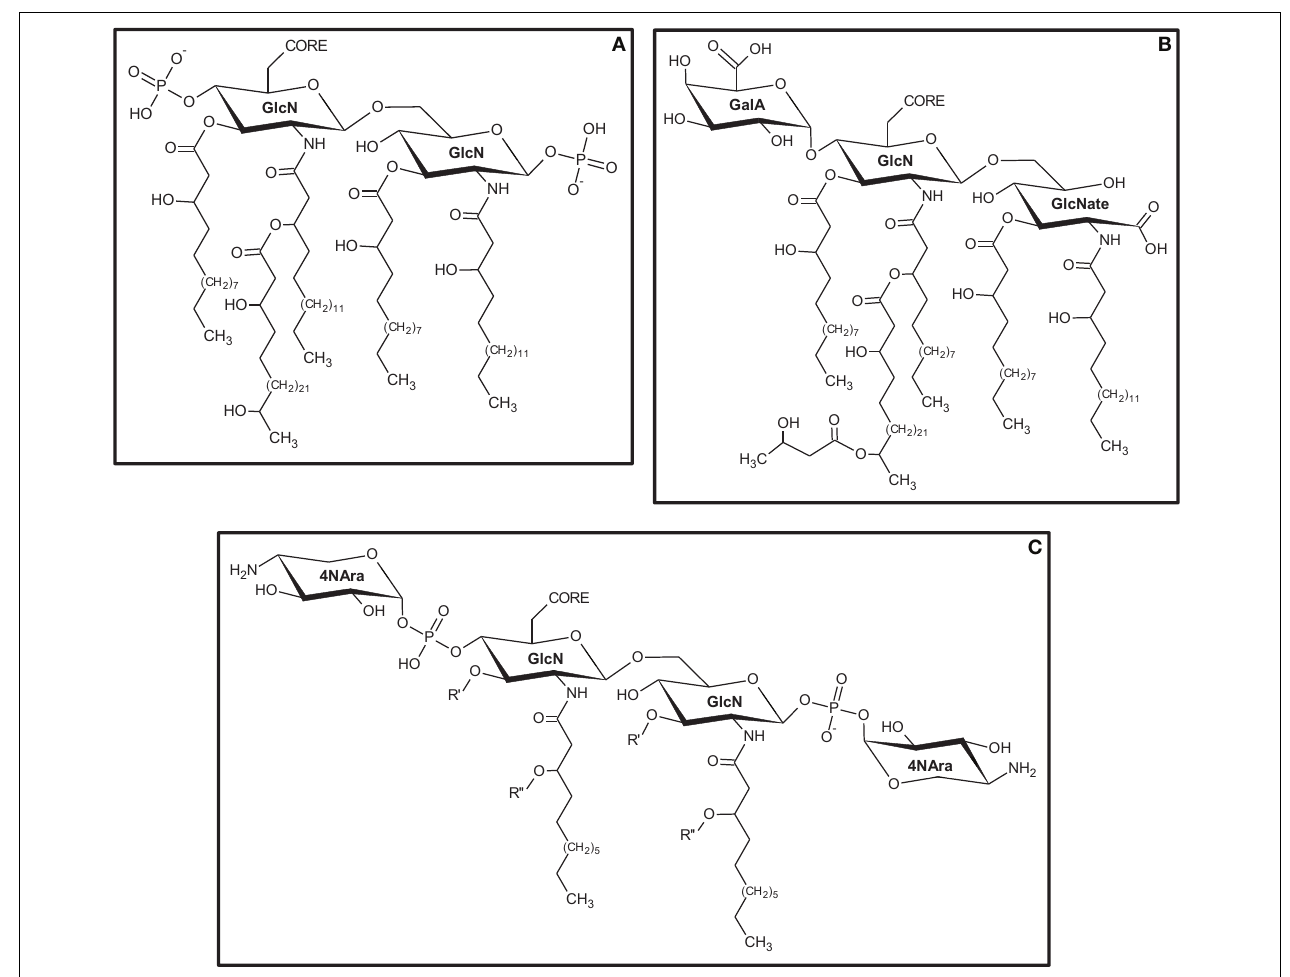
FIGURE 2 | Structural variations found on the lipid-A portion of LPS produced by diazotrophic bacteria. (A) Sinorhizobium meliloti ; (B) Rhizobium etli CE3; (C) Herbaspirillum seropedicae SMR1. Primary (R’)